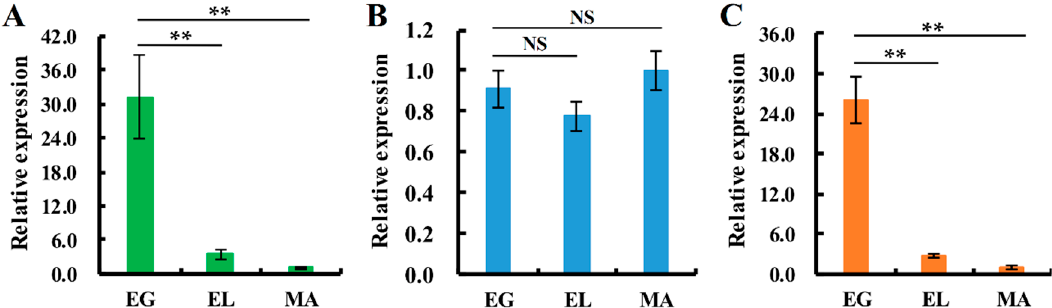
Figure 6. Expression patterns of sod genes in lamellae during different developmental stages of V. volvacea H1521. ( A ) the differential expression pattern of Cu-Znsod1 gene; ( B ): the differential expression pattern of Mnsod1 gene; and ( C ) the differential expression pattern of Mnsod2 gene. EG = egg stage; EL = elongation stage; MA = maturation stage. The gene expression levels are presented relative to the lamellae of MA stage. The means of four independent experiments are shown. The error bars show the standard error of the mean. Statistical analysis was performed using LSD test, ** p < 0.01, NS means no signi fi cant differences.